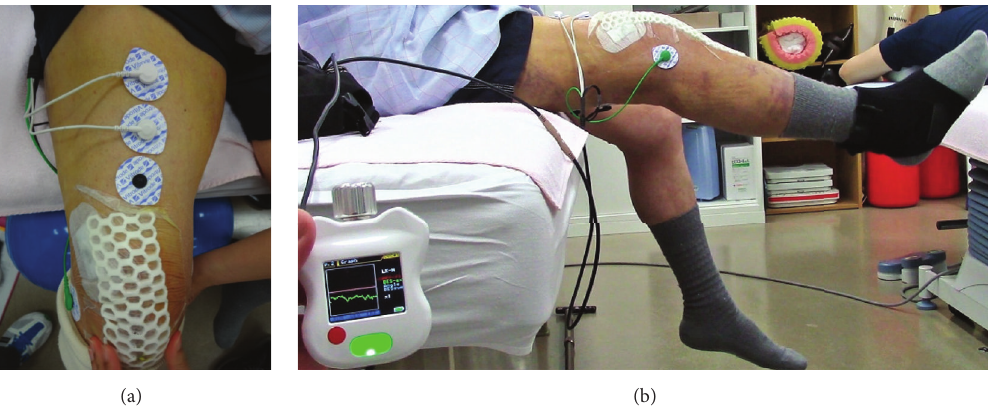
Figure 4: Bioelectric potential detection and simulation before single-joint hybrid assistive limb training. Electrodes were attached to the muscle belly of the quadriceps (a), and rectus femoris simulation (b) was performed. Electrodes were placed to avoid surgical